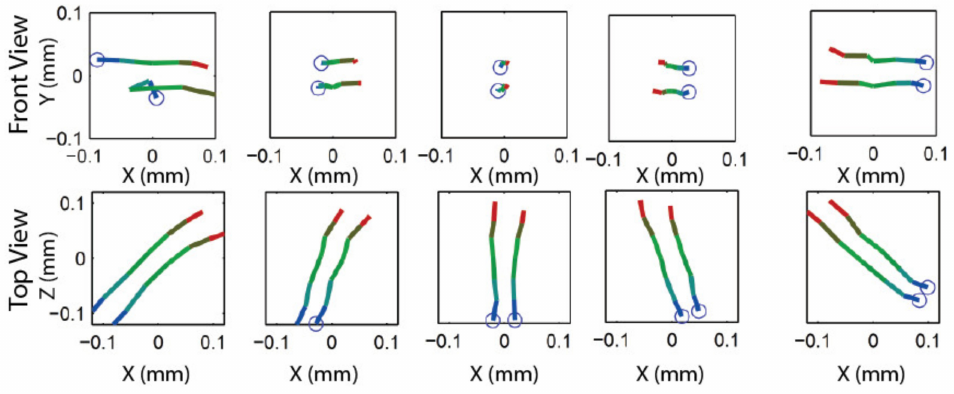
Figure 31. Effect of the mechanical distortion on the